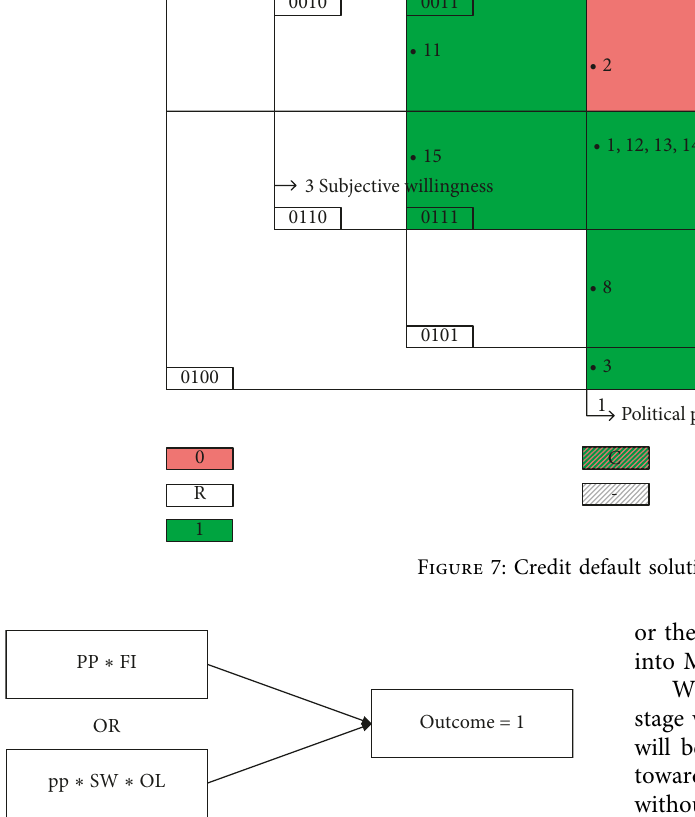
Figure 8: Credit default solution